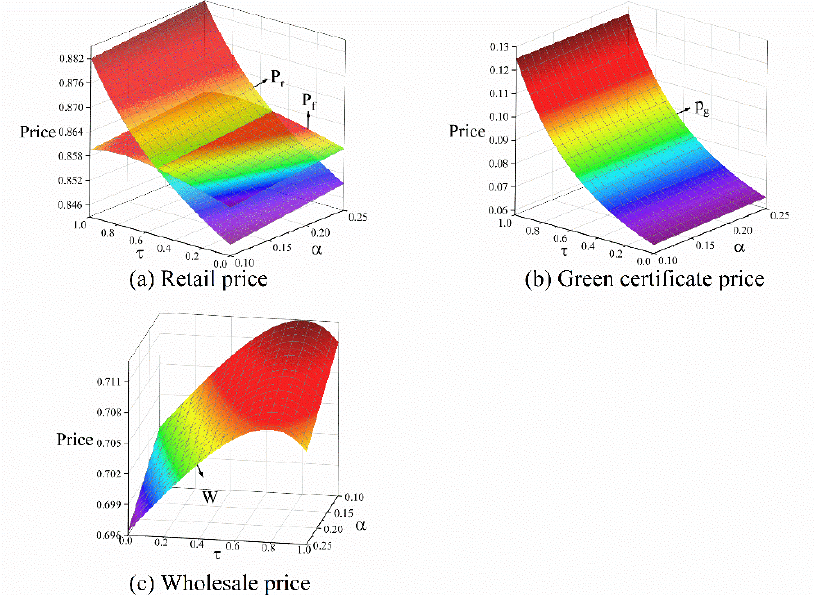
Figure 6. The trend of price under different levels of α and τ .